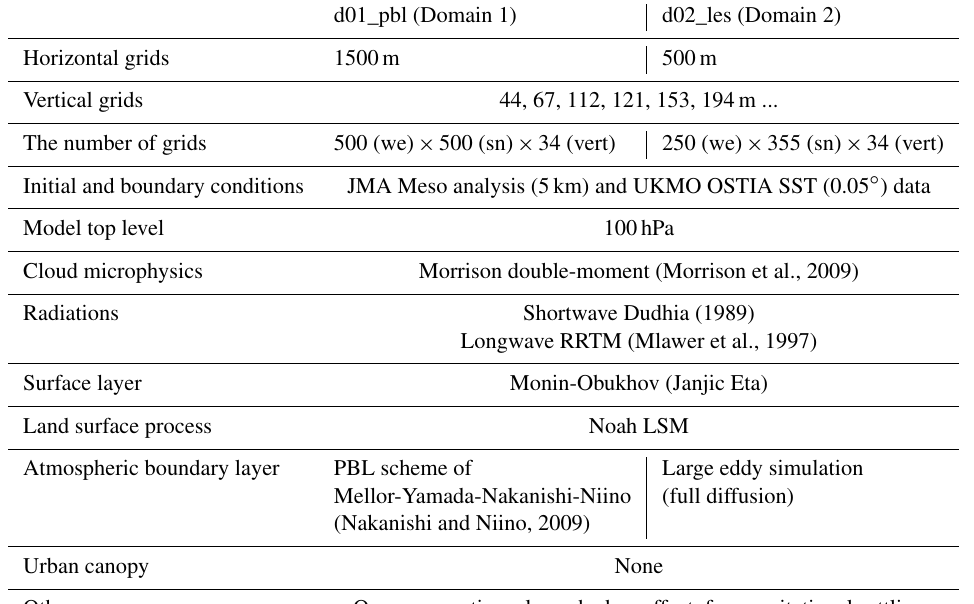
Table 1. Model setting of grids, boundary condition, and physics for d01 and d02.